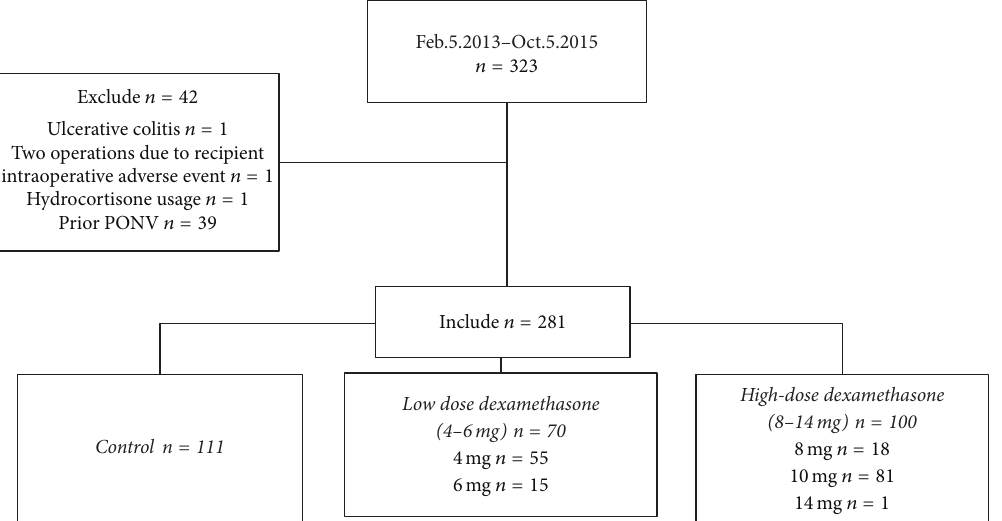
Figure 1: Flow chart of study design. PONV: postoperative nausea and